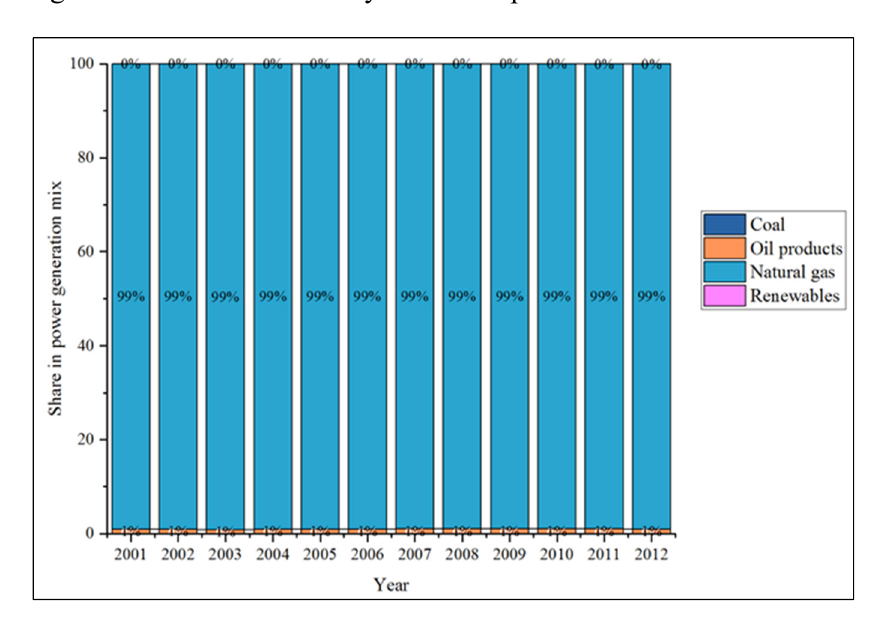
Figure 11. Brunei: power generation mix.